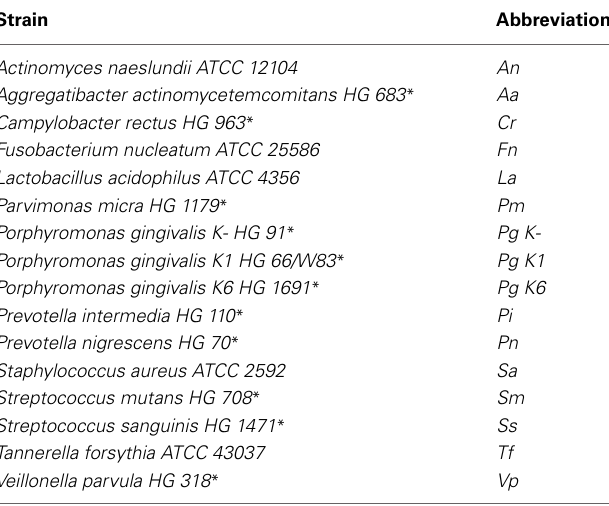
Table 1 | Bacterial strains and their abbreviations used in the